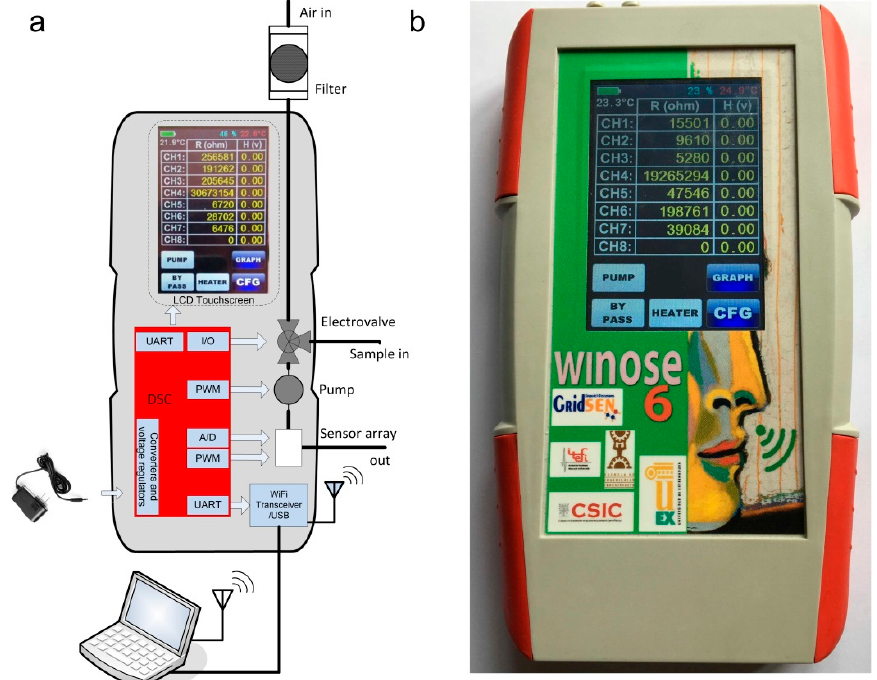
Figure 1. Wi NOSE 6: ( a ) Schematic; ( b ) photograph. Table 1. Sensor